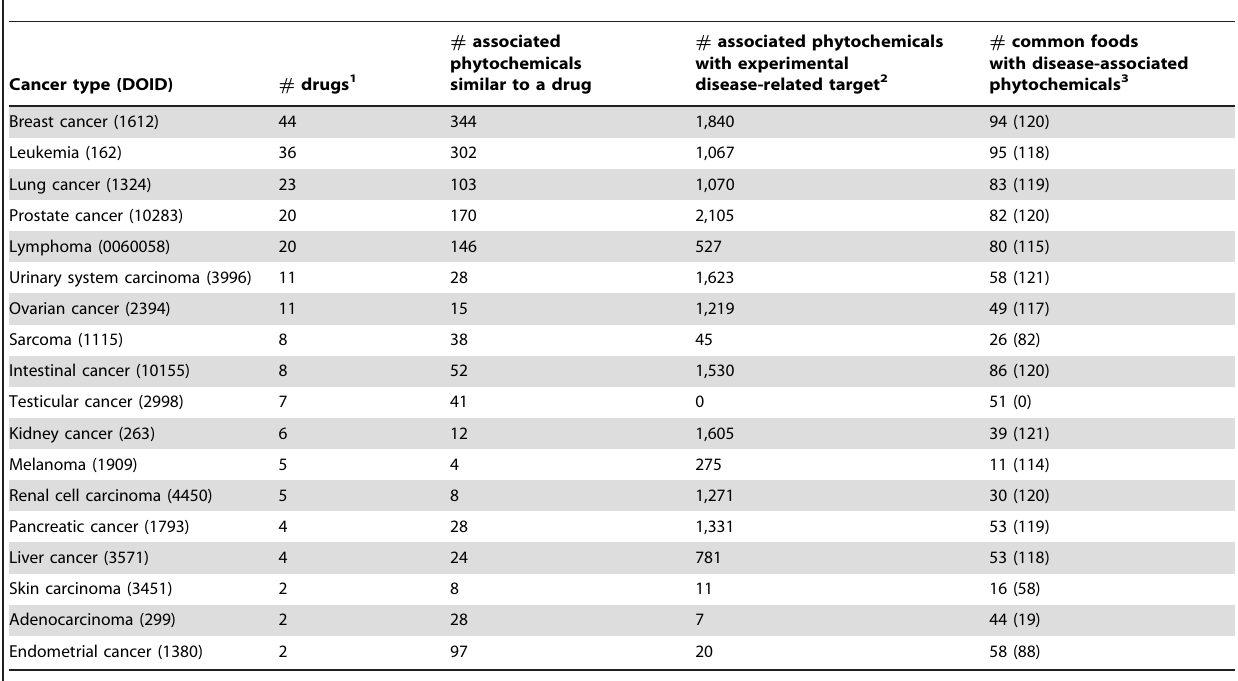
Table 1. Phytochemicals are associated with diseases via the approach illustrated in Figure 4.